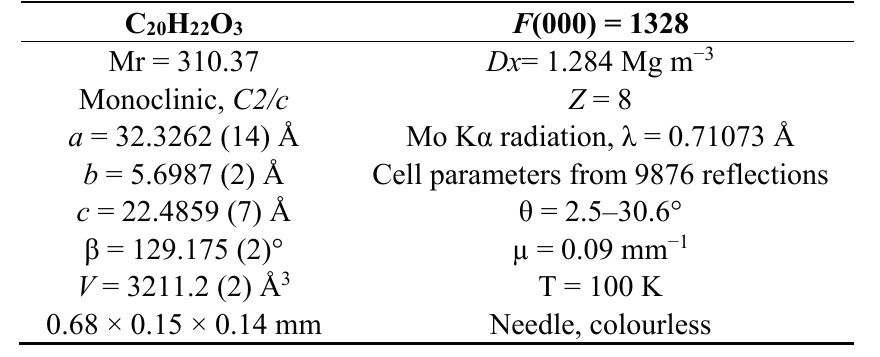
Table 1. Crystal data of 1 .